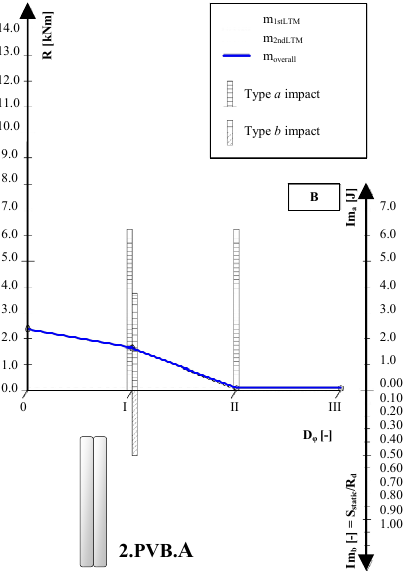
Figure 3: Element Safety Diagram for double layer, PVB-laminated, annealed glass beam.